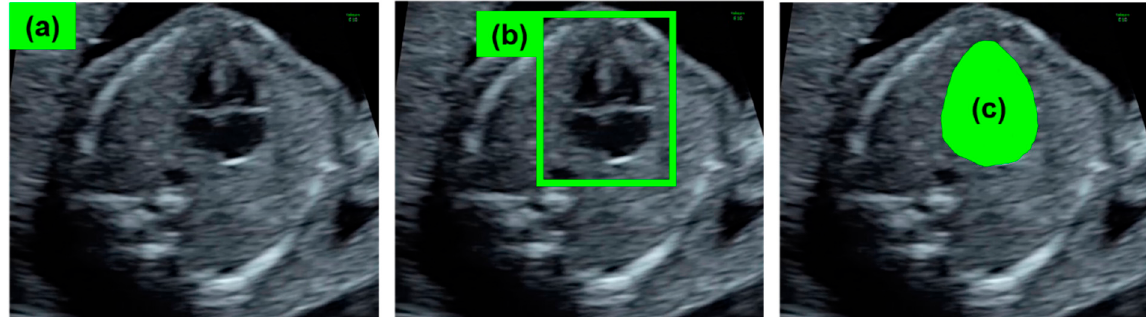
Figure 2. Fundamental algorithms generally used in US imaging analysis. ( a ) Image classification of whether the fetal US image contains a diagnostically useful cross-section such as a four-chamber view (4CV). ( b ) Detection of the fetal heart for evaluation of fetal heart structure. ( c ) Segmentation of the boundaries or regions of the fetal heart to measure the fetal cardiac index such as cardiothoracic area ratio (CTAR).